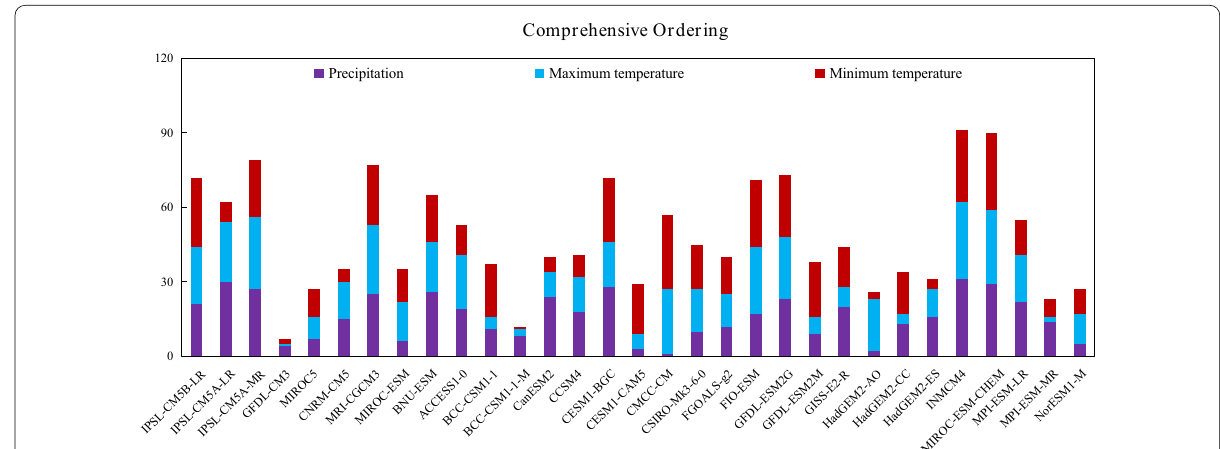
Fig. 4 Ranking of 31 climate models according to their comprehensive abilities to simulate precipitation, maximum temperature, and minimum